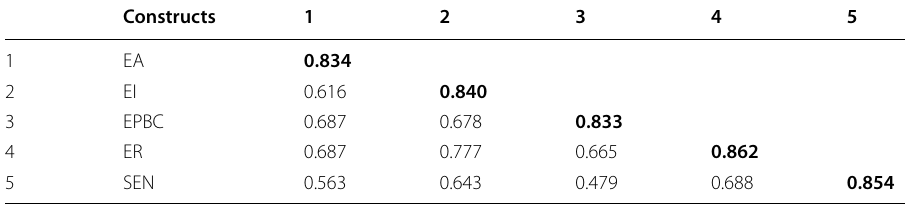
Table 5 Values of correlations between the LV and square roots of the AVE values in the main diagonal in the